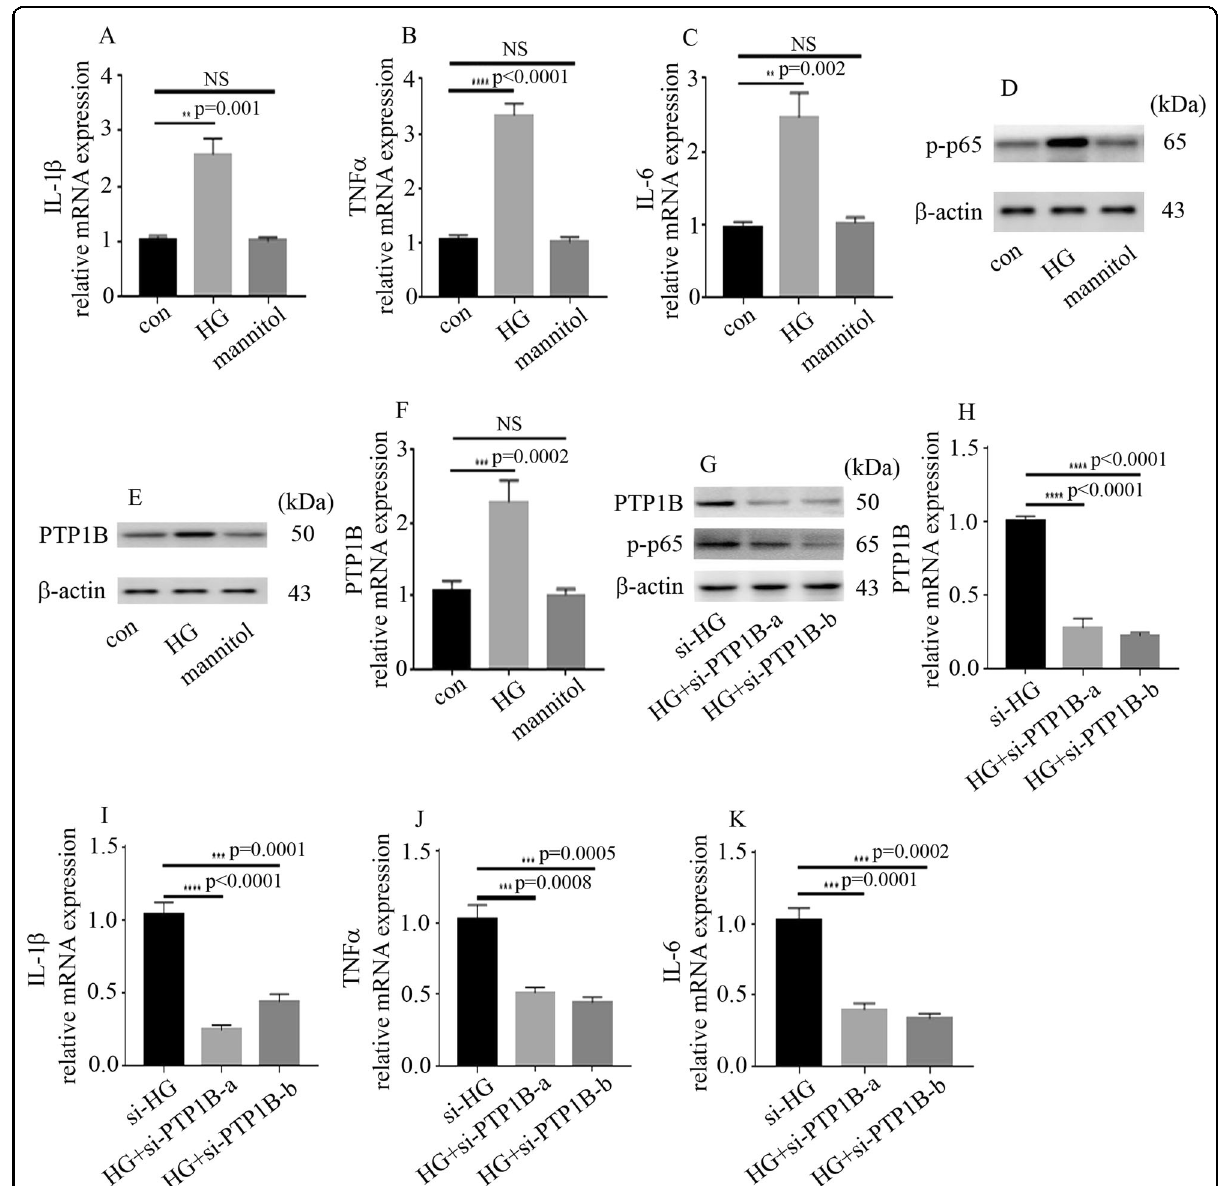
qPCR analysis of mRNA expression of IL-1 β , TNF α and IL-6. D western blot analysis of p-p65 levels in HUVECs. E western blot analysis of PTP1B levels in HUVECs. F qPCR analysis of mRNA expression of PTP1B. G Western blot analysis of PTP1B and p-p65 levels in HUVECs. H – K qPCR analysis of mRNA expression of PTP1B, IL-1 β , TNF α and IL-6. (* p < 0.05, ** p < 0.01, *** p < 0.001, **** p < 0.0001, n =